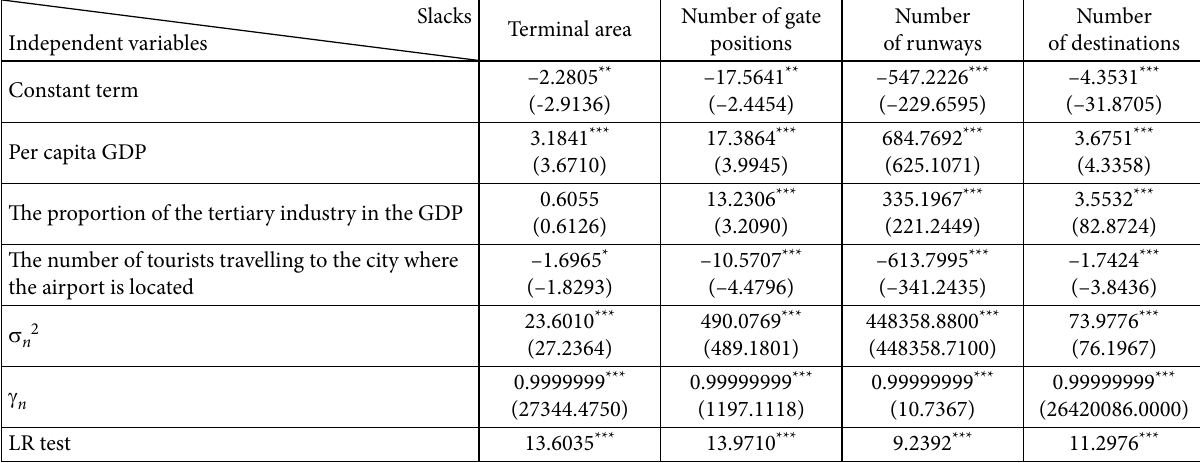
Table B.4. SFA estimation results in